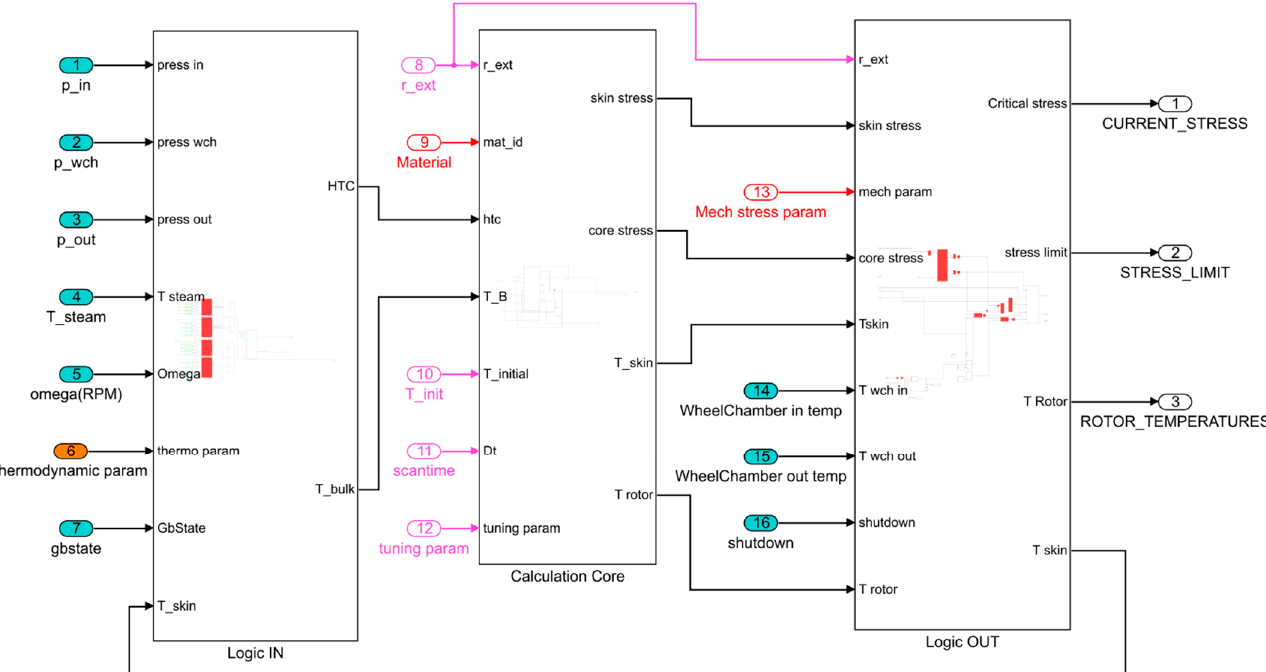
Figure 1. Rotor Stress Monitor, Matlab/Simulink implementation. Cyan represents the measured variables (pressures, temperatures, speed, generator breaker state, and shutdown command), orange represents the thermodynamic parameters, magenta represents the tuning parameters of calculation core, and red represents the mechanical stress